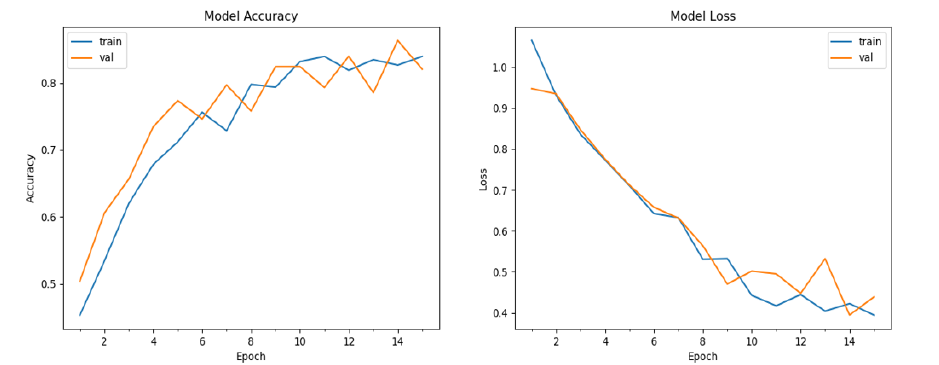
Figure 10. Accuracy and loss values of training and validation using 227 × 227 sized images (Setup III in Table